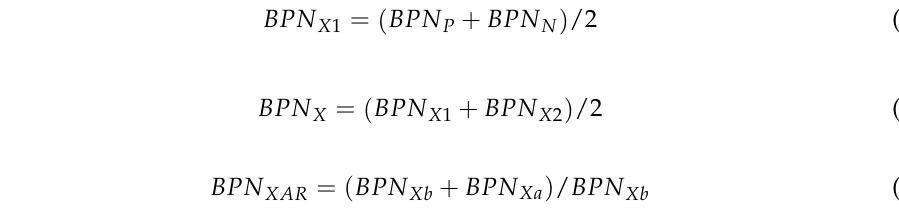
Figure 6. British pendulum test.